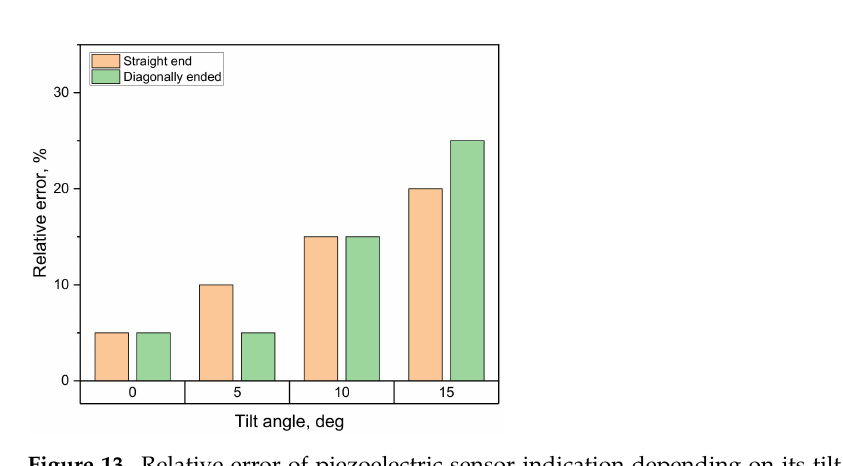
Figure 12. Relative error of piezoelectric sensor indication depending on its tilt angle in experimen- tal tests.